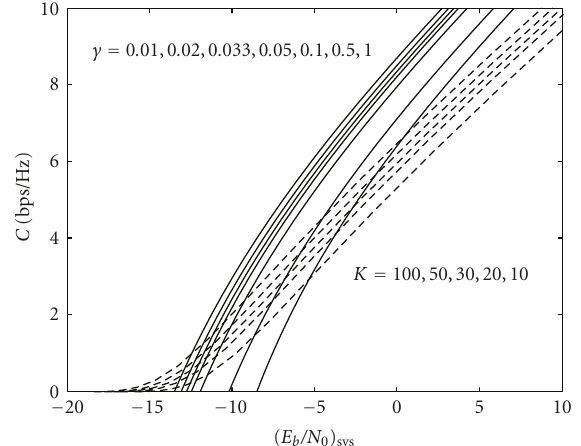
Figure 2: Comparison between PFS (dashed) and OSP (solid line).